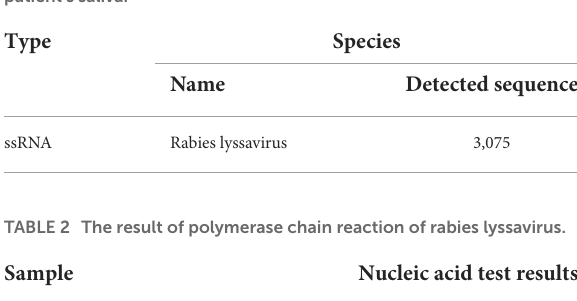
TABLE 1 The result of a high-throughput sequencing test of the patient’s saliva.